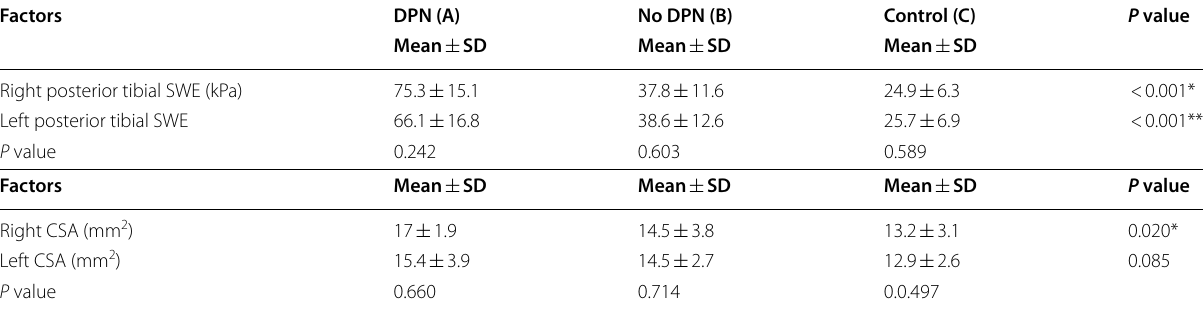
CSA cross-sectional area, DPN diabetic peripheral neuropathy, mm 2 millimeter square, kPa kilopascals, SD standard deviation, SWE shear wave elastography